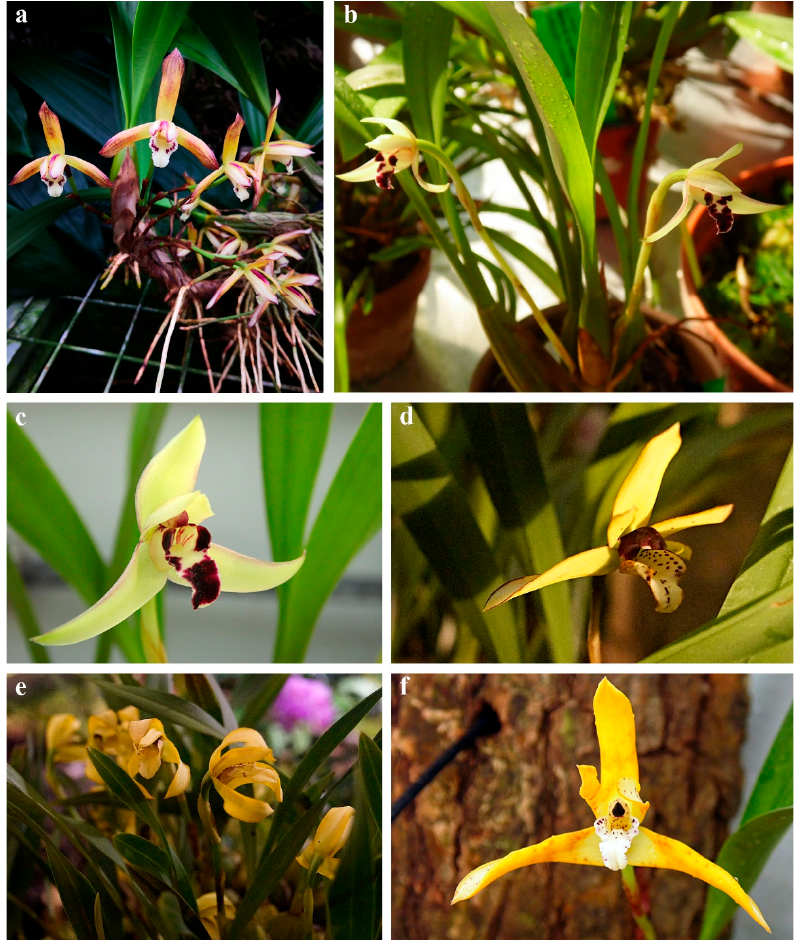
Figure 1. Flowers of Brasiliorchis species examined to date: ( a ) B. gracilis ; ( b,c ) B. marginata ; ( d ) B. picta ; ( e ) B. porphyrostele; ( f ) B. cf. porphyrostele . Photo. M. Lipi ń ska.